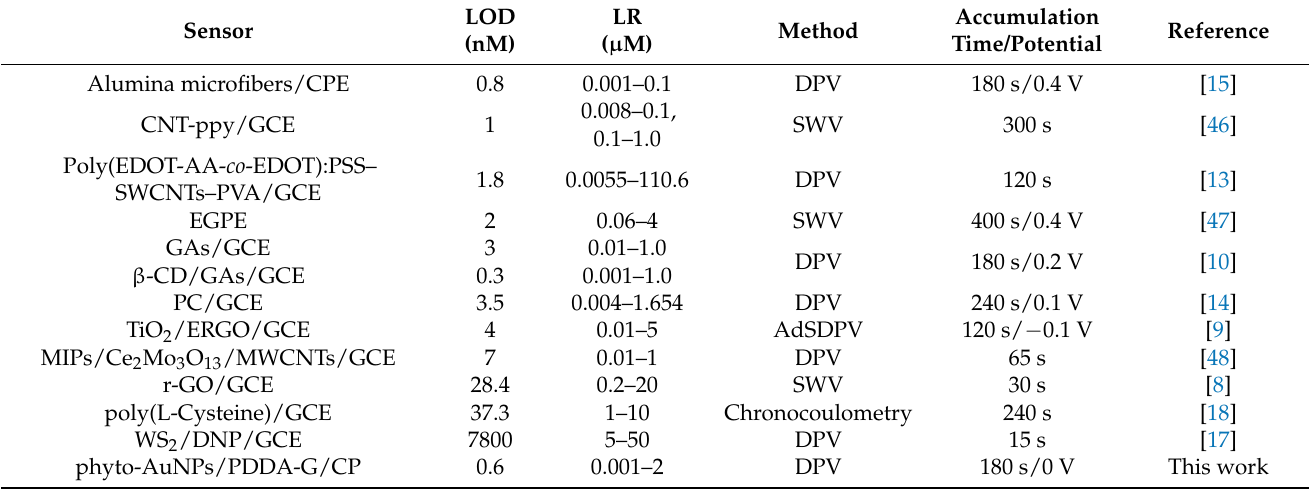
Table 1. Comparison of the analytical performance of phyto-AuNPs/PDDA-G/CP and the existing sensors for Ponceau 4R